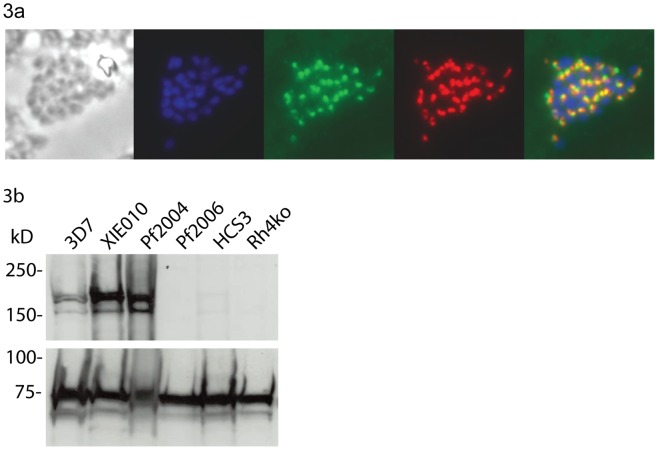
Expression of PfRh4 in clinical isolates and culture-adapted strains.(a) A representative example of a schizont from a clinical P. falciparum isolate with PfRh4 expression, as determined by immunofluorescence microscopy. Order of panels: phase, DAPI stain (labels nucleus), anti-Ron4-Alexa 488, anti-Rh4-Alexa-597, overlay. (b) Western blots showing expression of PfRh4 by P. falciparum isolates recently adapted to in vitro culture. Proteins were extracted from schizonts and the membrane was probed with anti-PfRh4 antibodies (upper panel) and anti-HSP70 antibodies (lower panel) as a loading control. The positions of molecular weight standards are indicated on the left. Isolates tested were 3D7, XIE (from PNG), Pf2004 (Ghana), Pf2006 (Ghana), HCS3 (Thailand) and a W2mef-PfRh4 knockout line (Rh4ko).